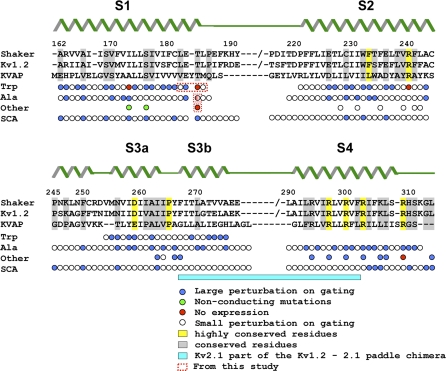
Comparison of Mutational Data with SCA ResultsHighly conserved residues (over 80 % identity in the multiple sequence alignment) are highlighted in yellow and are likely SCA-insensitive (see text). Moderately conserved residues (40–80% identity) are highlighted in gray. The impacts of mutations to Ala [17], Trp [22,23], or other residues within the voltage sensor are shown under the alignment. The mutations in the “Other” row are as follows: Arg or Leu or Pro on I173 and S176 on S1 [40], Val on T184 on S1; Asn on S2 and S3 [22,23]; Gln on S4 [41,42]; Val on L314 (S4) [43]. Blue filled circles represent mutations that cause a large perturbation in gating energy (>1 kcal/mol), whereas open circles indicate small perturbation in gating energy (<1 kcal/mol). Red filled circles represent no expression and green filled circles indicate expressed but non-conducting mutations. Half-red circle represents no expression in Shaker but small perturbation in Kv2.1. The cyan bar represents the Kv2.1 part of the paddle chimera. Mutations that are enclosed with dotted lines were produced and analyzed in this study. The numbering is based on rat Kv1.2.